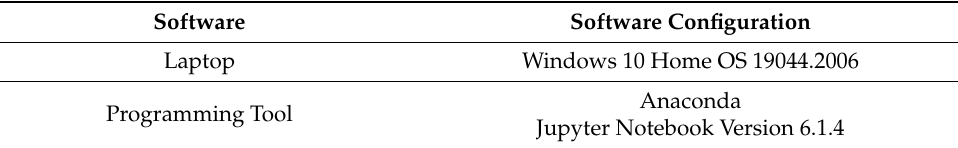
Table 3. Software Configuration.